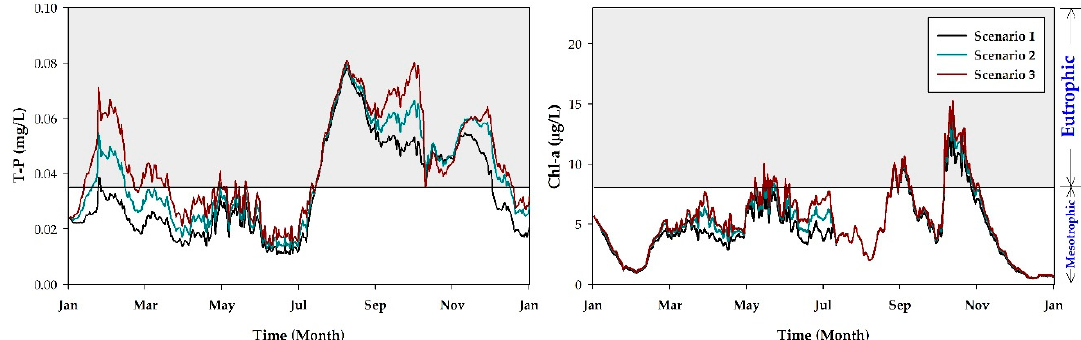
Figure 10. Annual changes in the TP and Chl-a concentrations and assessment of water quality affected by sediment flux.